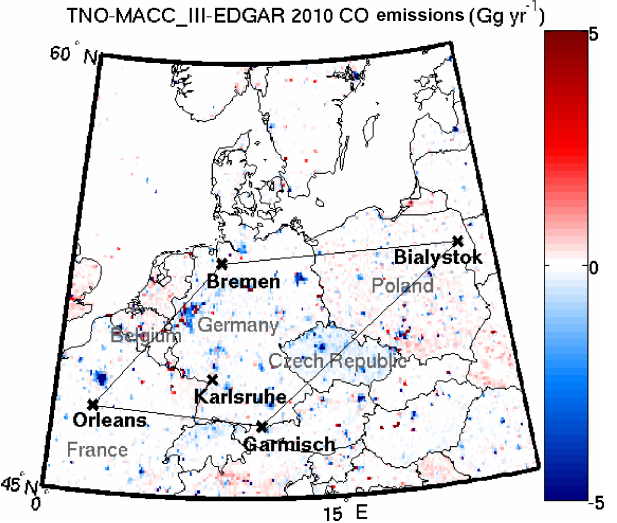
Figure 8. This map shows the difference between the TNO- MACC_III methane emissions and the EDGAR emissions for the year 2010. The labeling and coloring follows that in Fig.